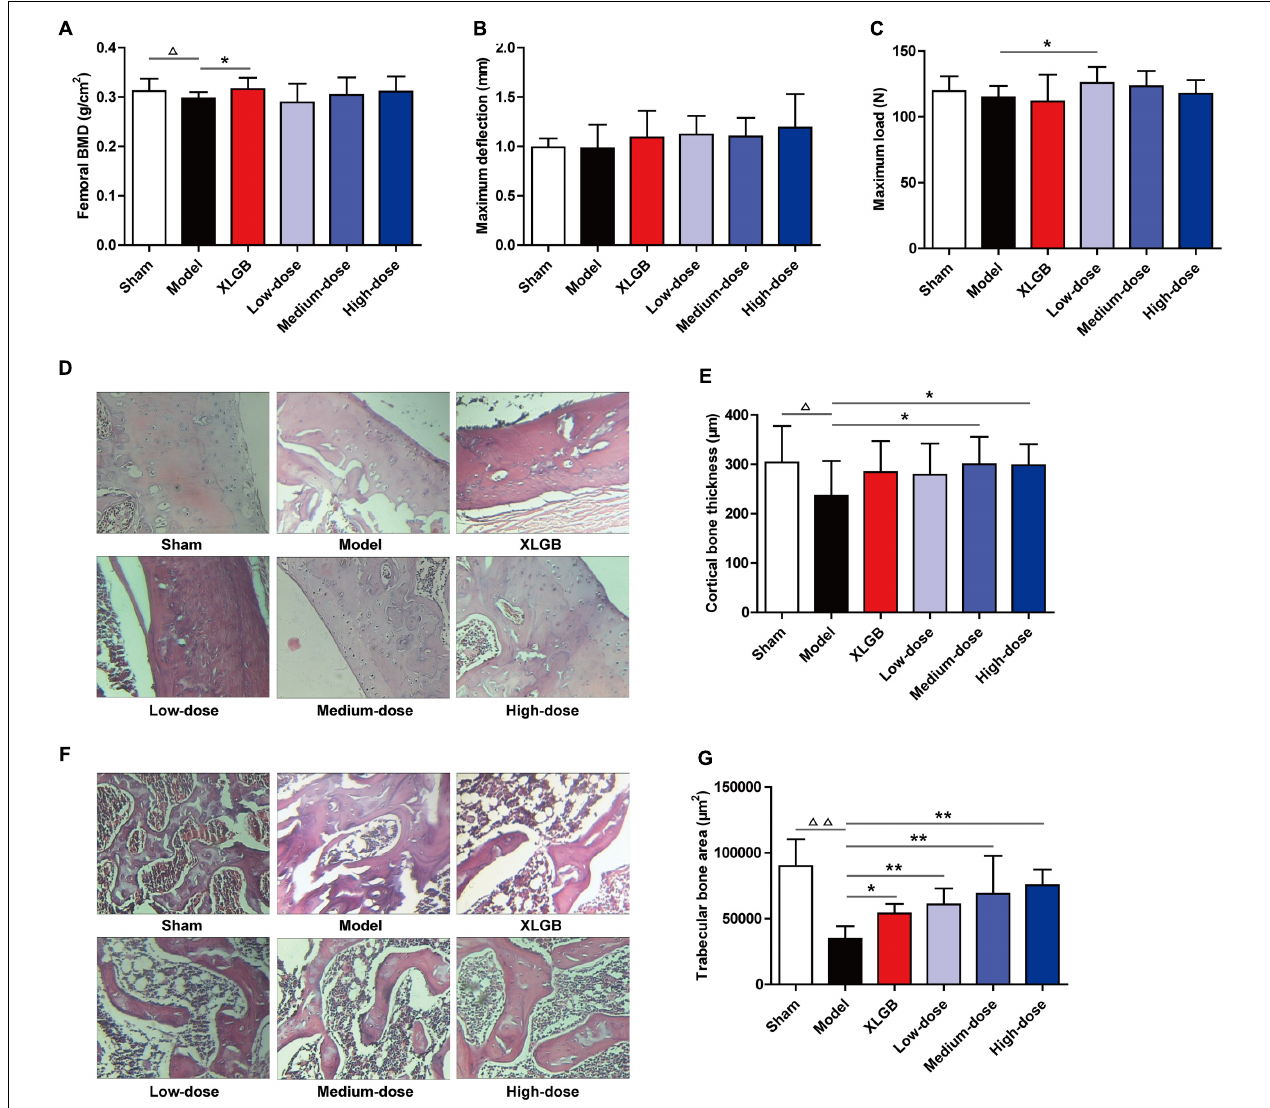
FIGURE 3 | Pu-erh tea extract preserved bone quality in OVX rats. Femoral bone mineral density (BMD) (A) , maximum deflection (B) , and maximum load (C) in each group. Cortical bone tissue was stained with hematoxylin and eosin (H&E) (D) , and cortical bone thickness was calculated (E) ; and trabecular bone tissue was stained with H&E (F) , and the trabecular bone area was calculated (G) . Representative images were acquired using a medical image analysis system, and the original magnification was × 400. All data are presented as the mean ± SEM ( n = 10). (cid:77) P < 0.05 and (cid:77)(cid:77) P < 0.01 versus the sham group; and ∗ P < 0.05 and ∗∗ P < 0.01 versus the model